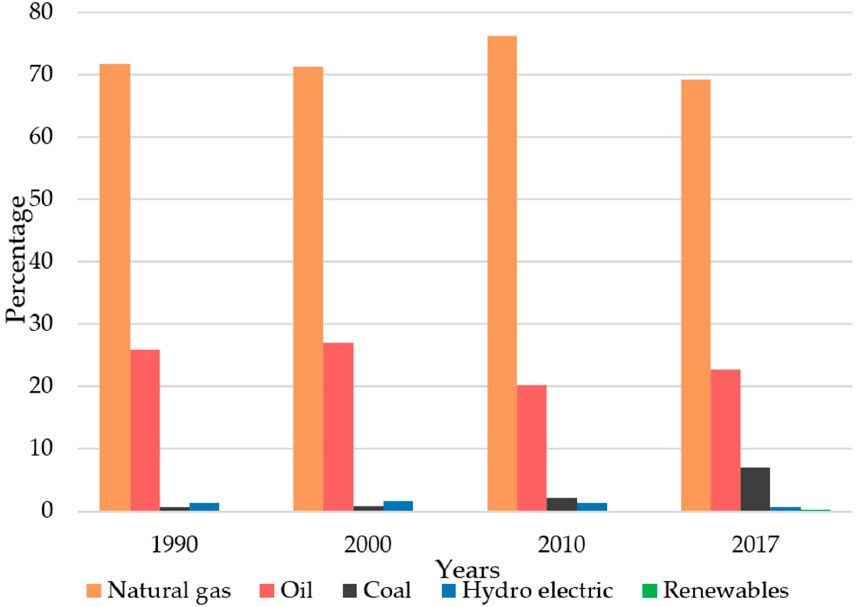
Figure 10. Energy mix of Bangladesh shows the dependence entirely on fossil fuels (99.1%) [21].